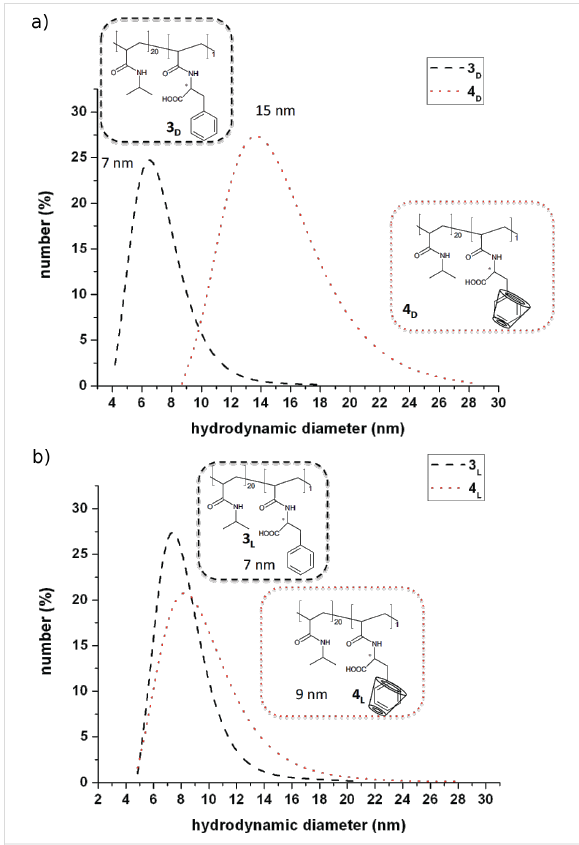
Figure 6: Hydrodynamic diameters of the copolymers and their corres- ponding complexes with RAMEB-CD a) L-phenylalanine containing copolymer b) D-phenylalanine containing copolymer (1 mg/mL, pH